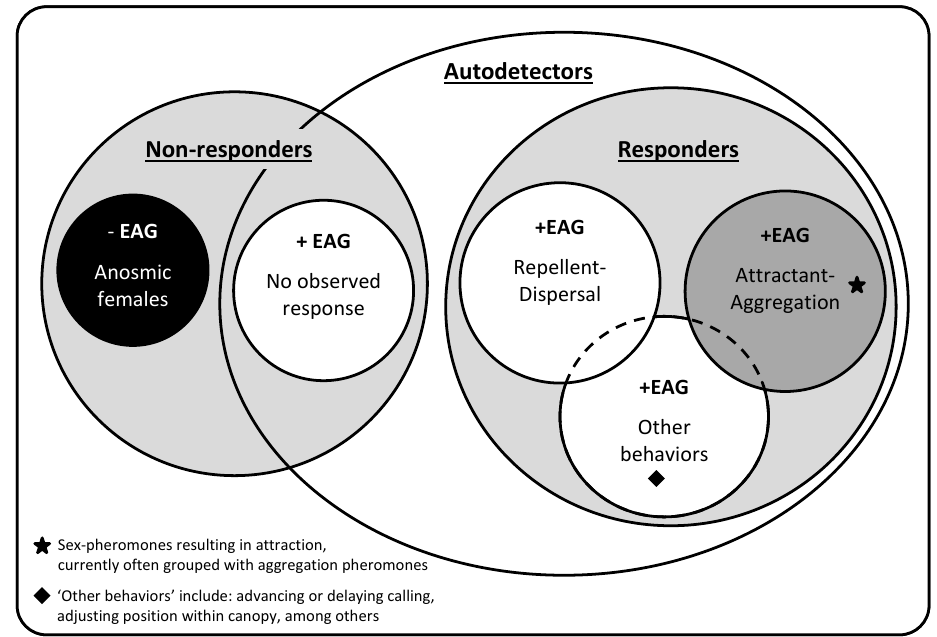
Figure 1. Venn diagram of behavioral (repellence, attraction and dispersal, and aggregation) and electrophysiological (electroantennogram (EAG)) responses, and no responses, of females to conspecific-produced sex pheromones.